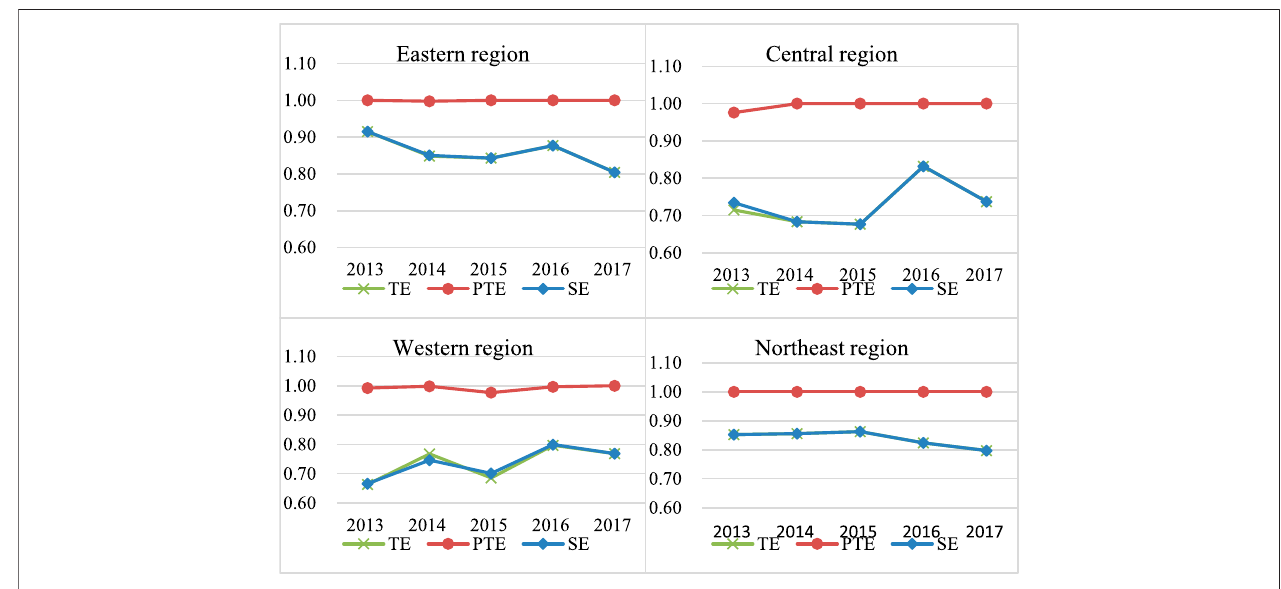
FIGURE 6 | Statistical description of indicators by year and by